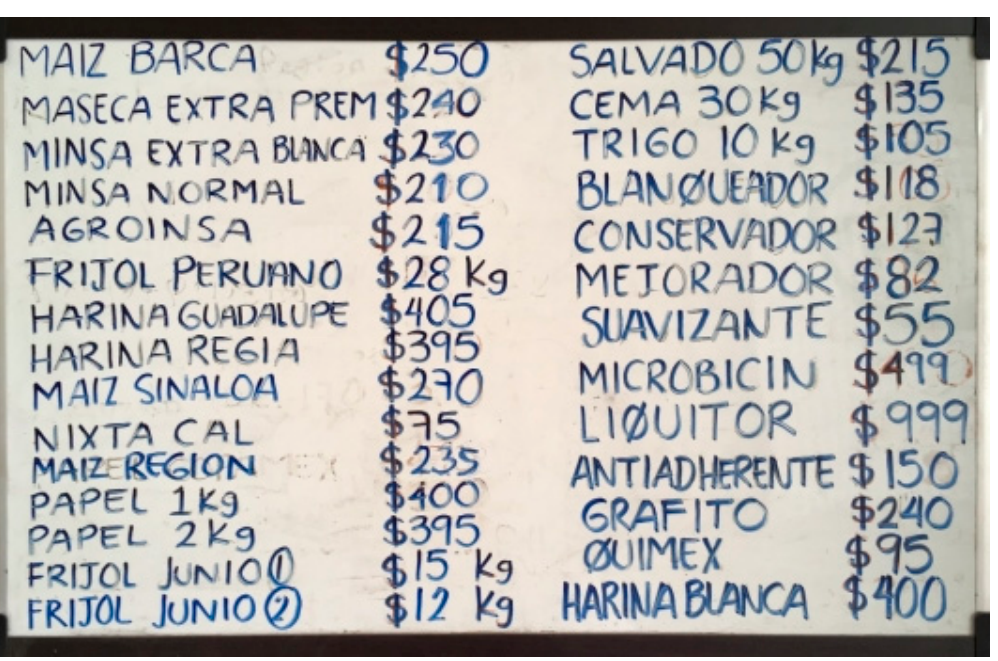
Figure A1. Prices of maize-related products for sale at The Morelia Supply Center (MSC) dispenser.